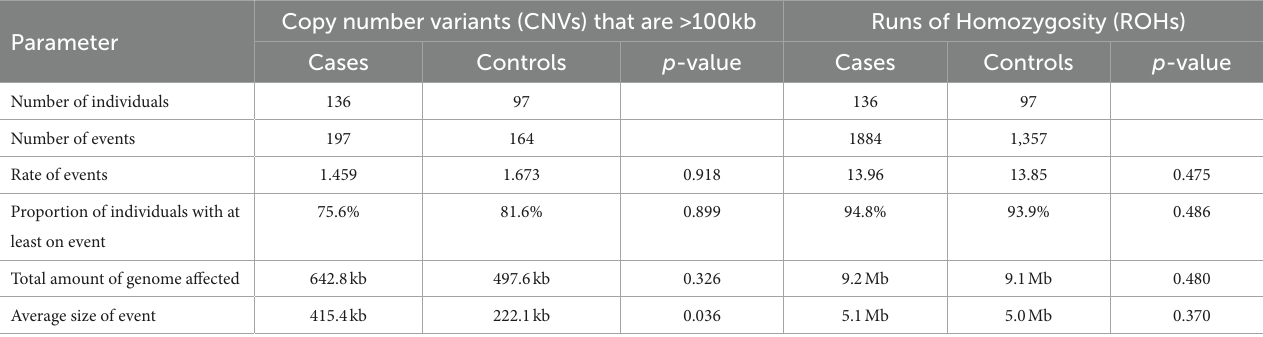
TABLE 2 Number of samples and events and a comparison of the rate of events.